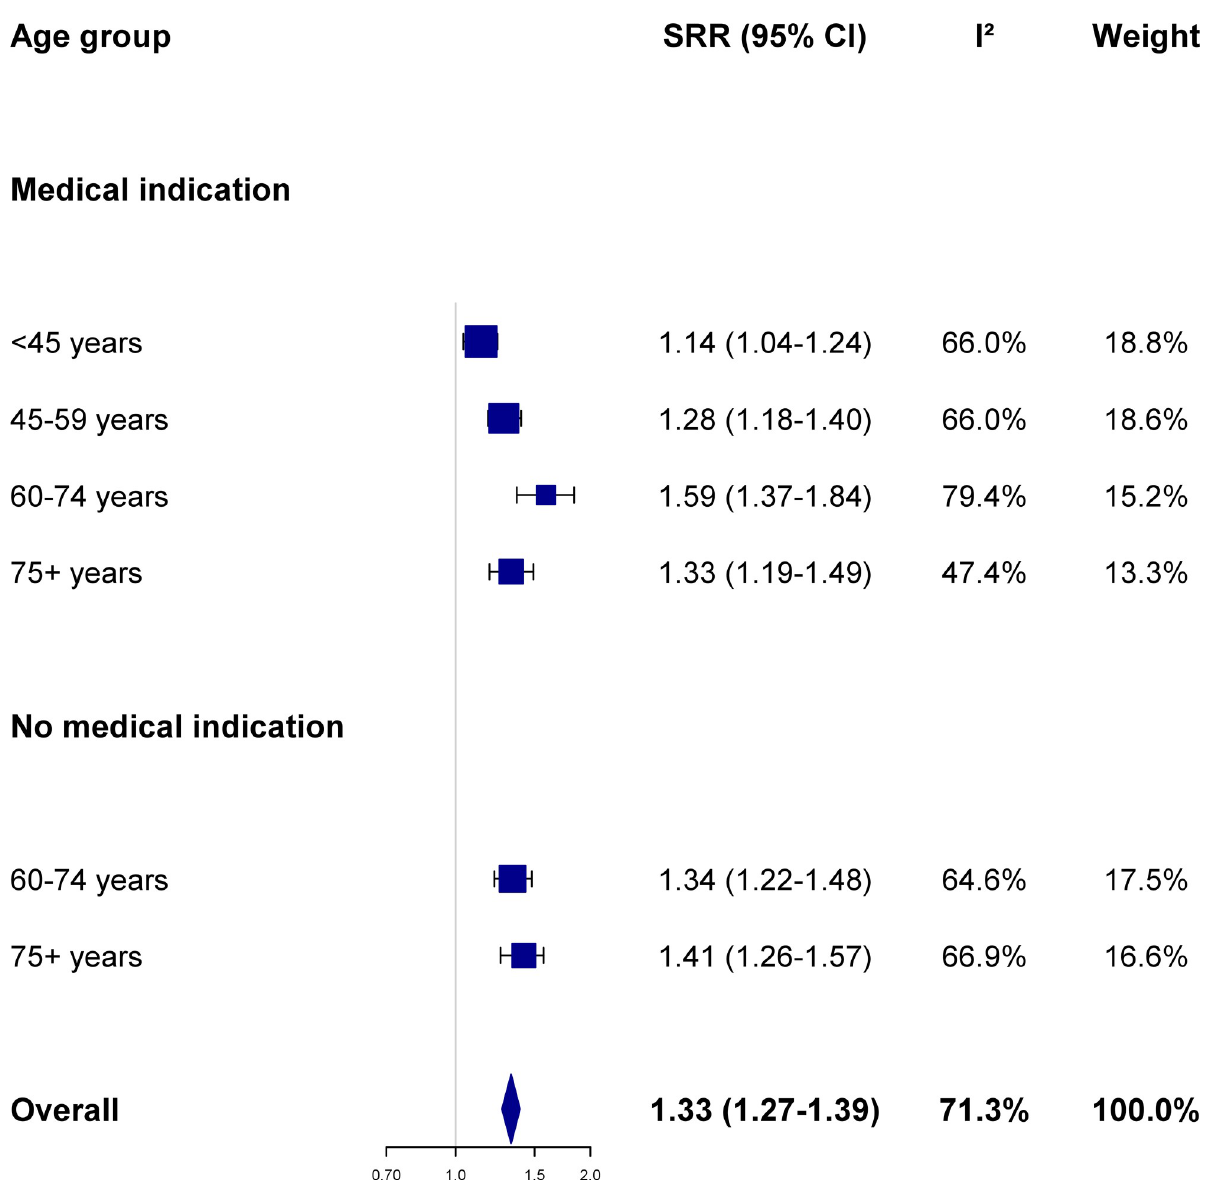
Fig 2. Association between influenza vaccination and the risk of acute respiratory infection according to age group and presence of medical indication. Summary risk ratio (SRR) and 95% confidence intervals (CI) were calculated by pooling season-specific risk ratio using random effects meta-analysis models; between-seasons heterogeneity was quantified using the I 2 statistics (see text for details; season-specific risk ratio were provided in S2 Table). The Netherlands, seasons 2006/07 to 2015/16.